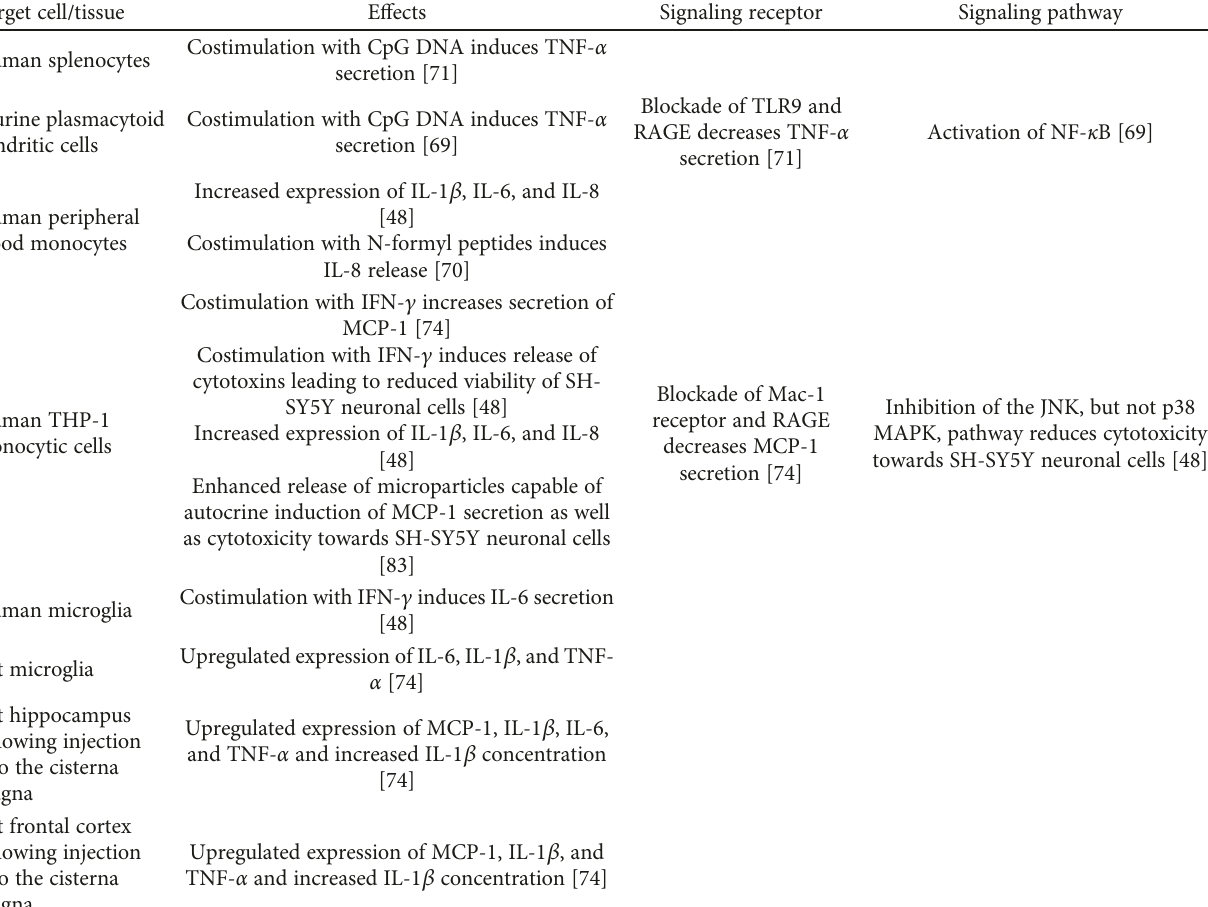
Table 2: E ff ects of extracellular TFAM on di ff erent cell types and signaling mechanisms activated in the target cells. Target cell/tissue E ff